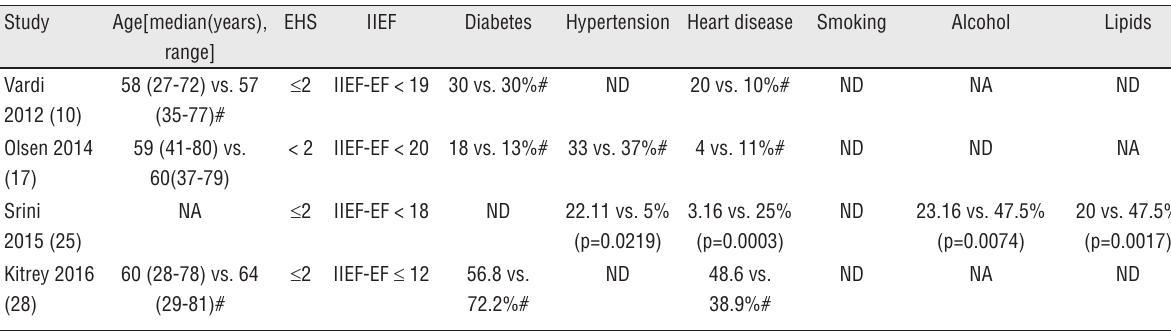
Table 3 - Baseline characteristics of study population in 4 RCTs for